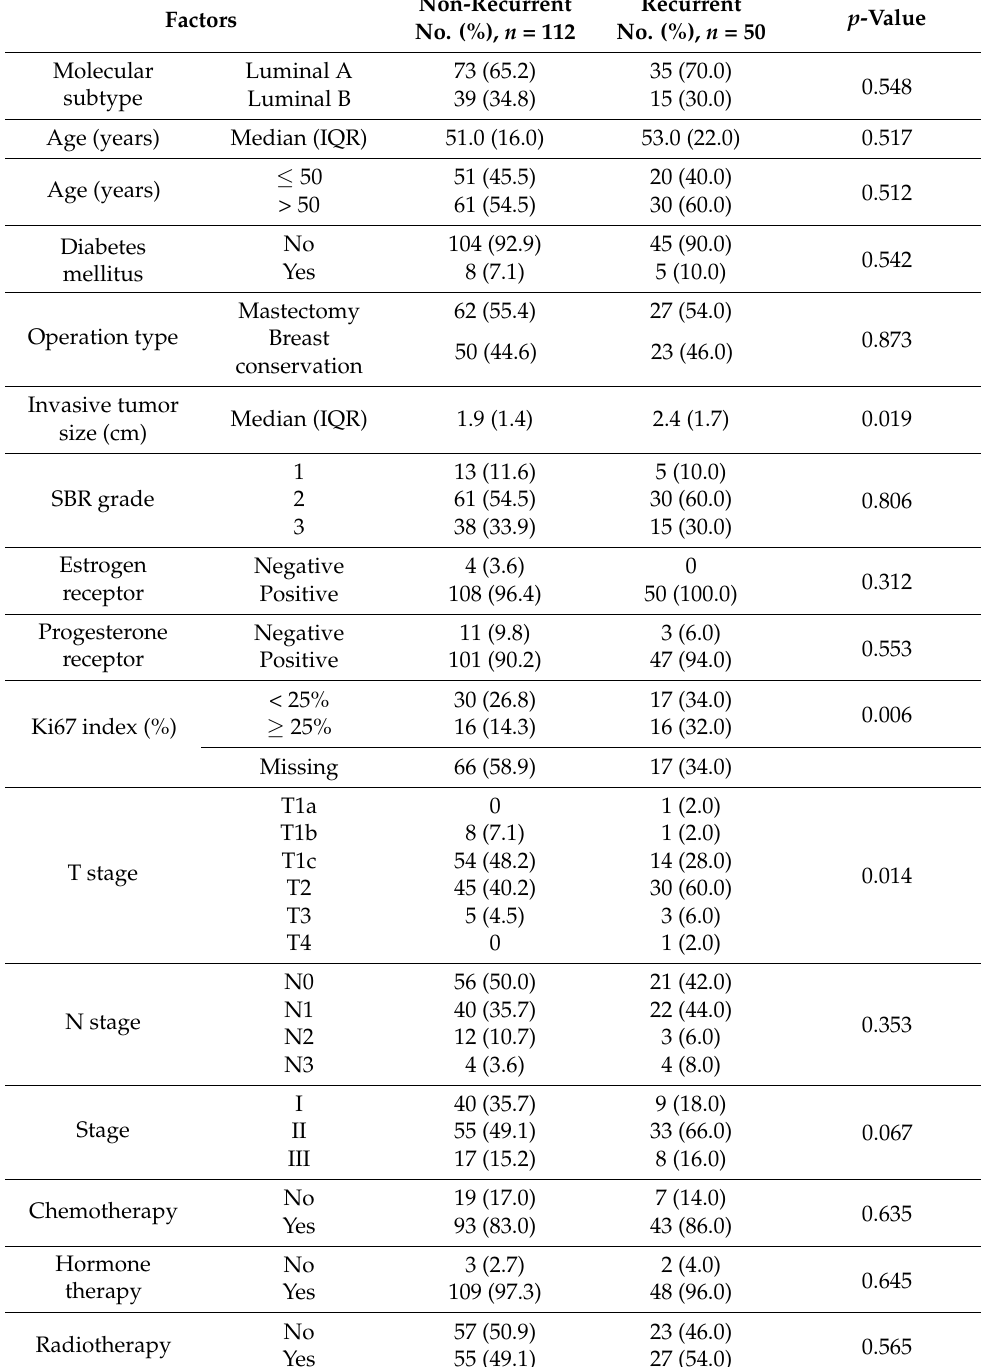
Table 1. Clinical properties of